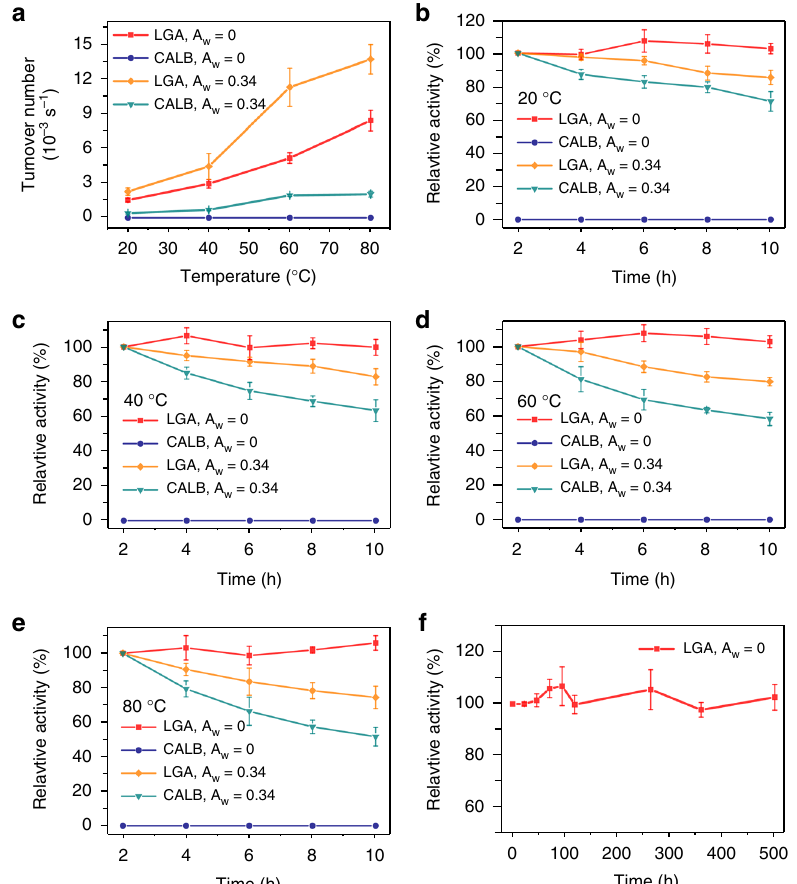
Fig. 6 The long-term operation of LGA3 and CALB at different conditions. a The temperature dependence of turnover numbers of LGA3 and CALB at A w = 0 and A w = 0.34; b – e the thermostability of LGA3 and CALB at A w = 0 and A w = 0.34 at 20, 40, 60, and 80 °C; f the activity of LGA3 during a continuous operation for 500 h at 20 °C. Error bars represent the s.d. of three replicates. Source data are provided as a Source Data fi